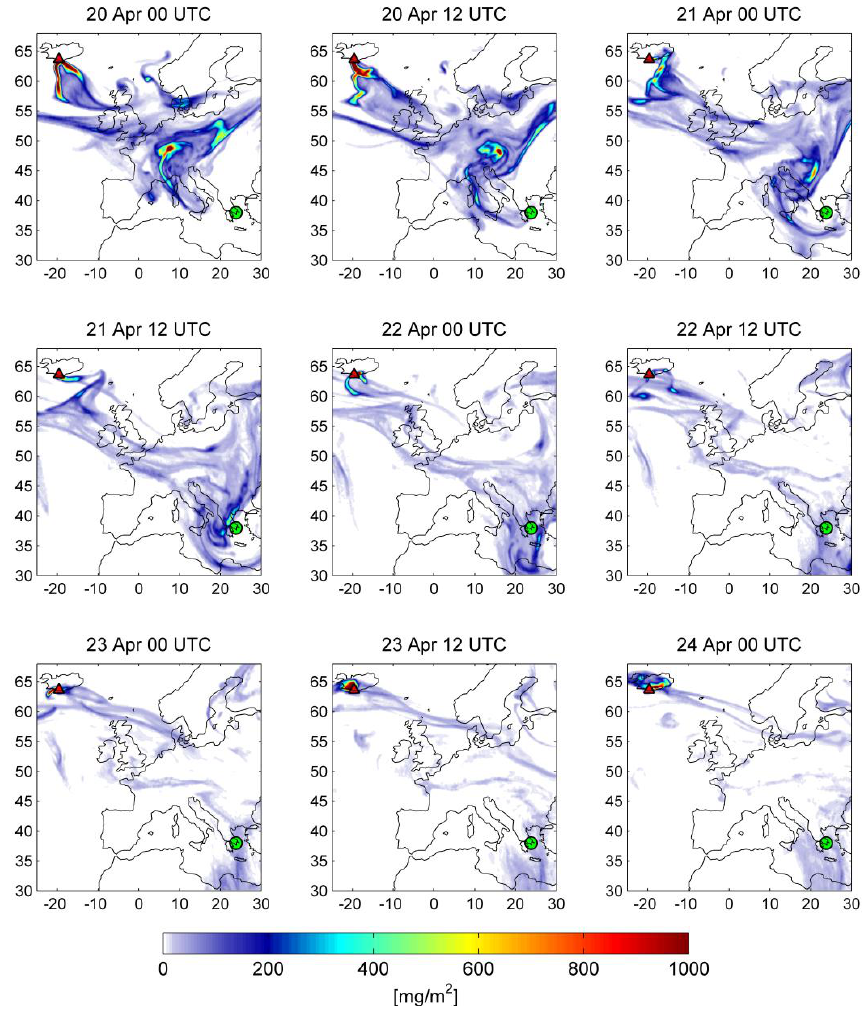
Fig. 1. FLEXPART simulations of the Eyjafjallajökull volcanic ash dispersion (total column in mgm − 2 for all 25 particle size classes) for the period of 20 (00:00UTC) to 24 April 2010 (00:00UTC). The position of the Athens lidar station is marked by a green circle, while the location of the volcano is shown by a red